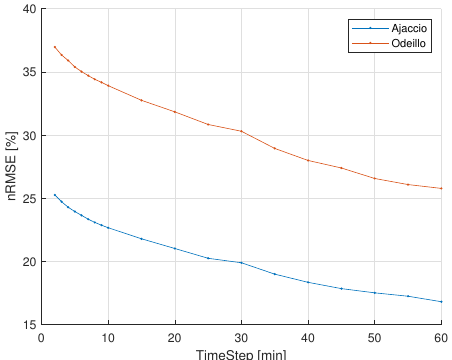
Figure 12. Very short term and short term results at one hour horizon.